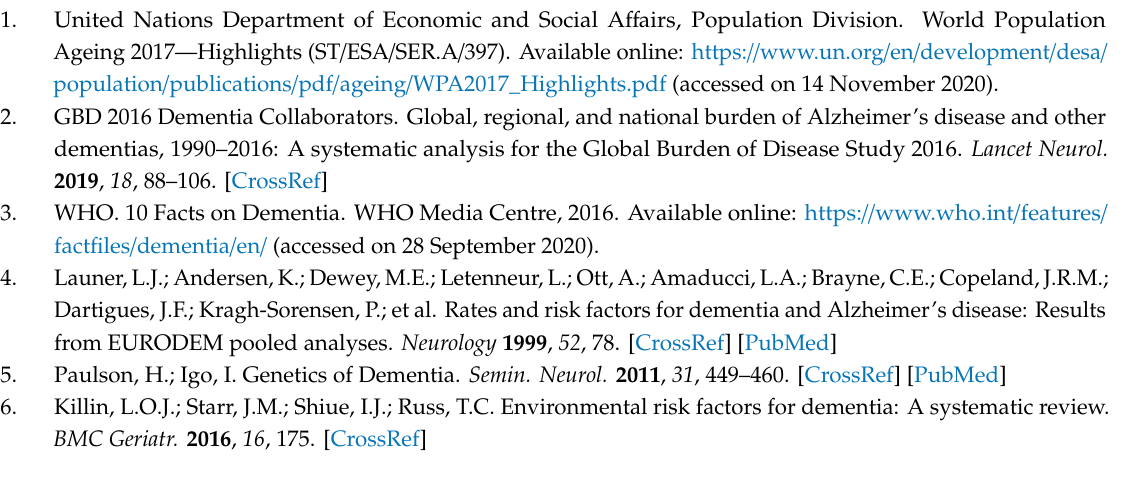
Figure S1: Inhibition of AChE and BuChE by galantamine. Figure S2: DPPH radical scavenging activity of plant extracts. Figure S3: Toxicity of plant extracts to neuronal cells. Table S1: Reported phytochemicals with anti-cholinergic